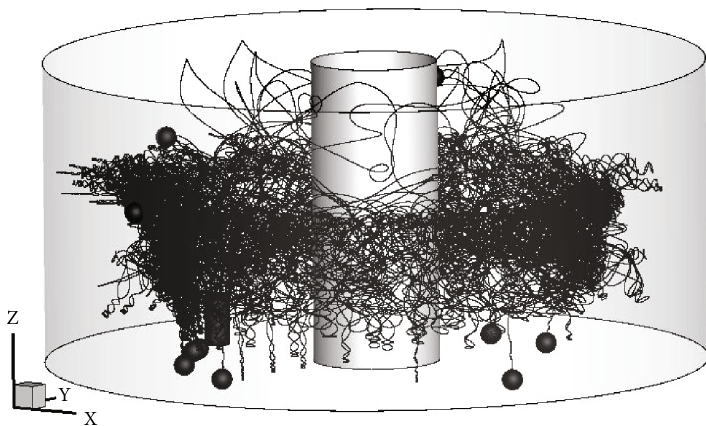
Figure 14: Primary electron trajectories without collision